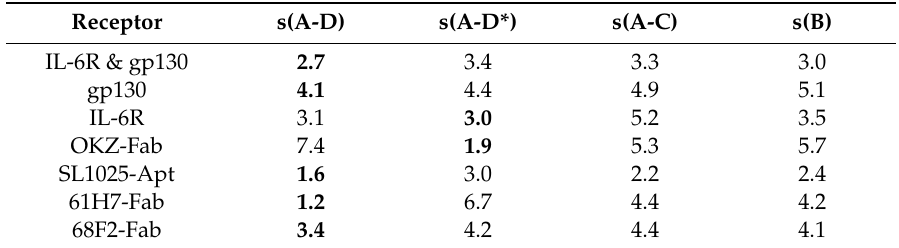
Table 2. Table of topological complementarity index, ToCI, using four di ff erent contact positions. Lowercase s (#) denotes the ToCI value, calculated putting the input / output contacts on IL-6 helices (#). Data refer to the rr spectra reported in Figure